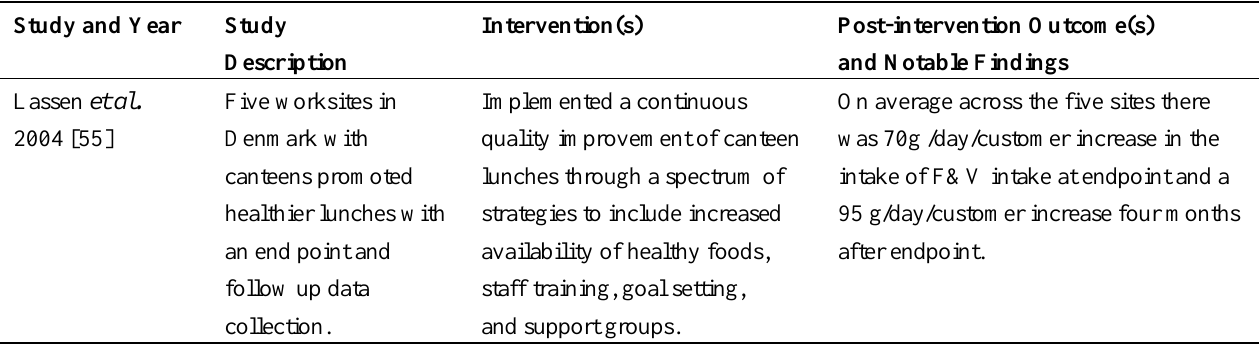
Table 2. Healthy Food Procurement Programs in